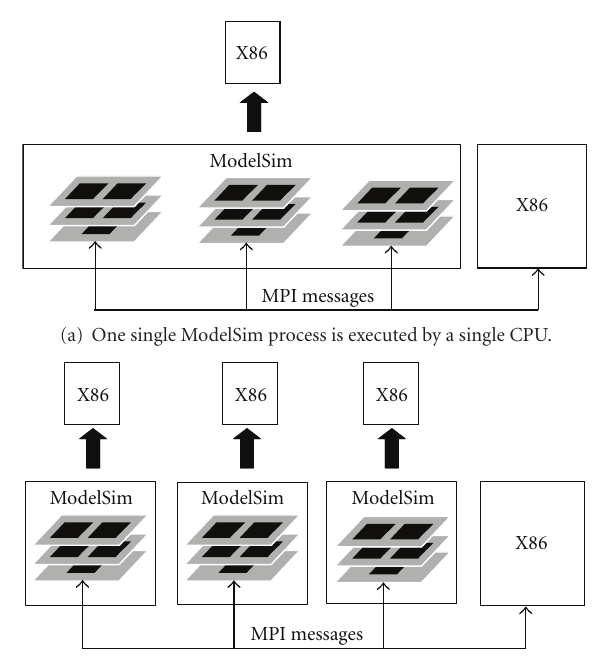
Figure 6: Two options to simulate multiple M2 Module Stacks.